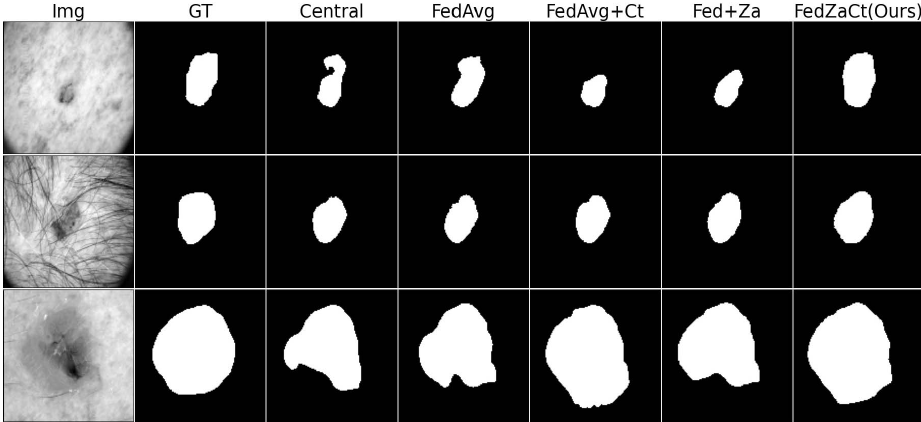
Figure 3. The comparison of qualitative examples on the public HAM10000